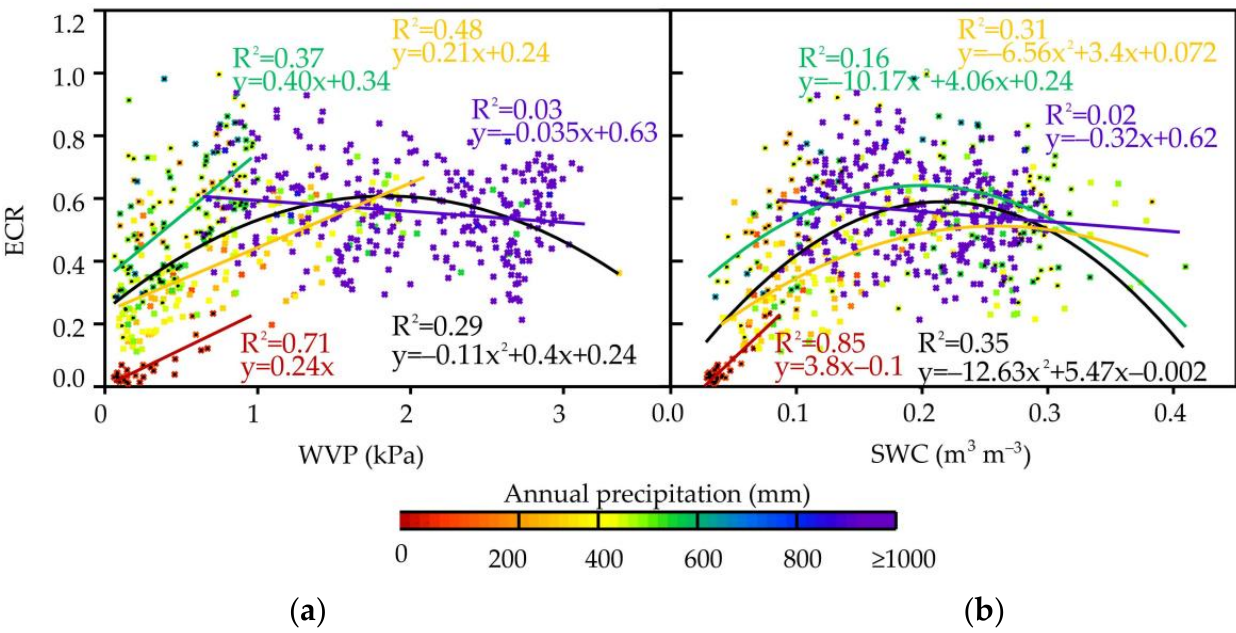
Figure 7. Correlation between ET conversion rate (ECR = LE/Rn) and WVP ( a ) and SWC ( b ). The black fitting line represents the result of all points. Figures 8–11 are similar to Figure 7.